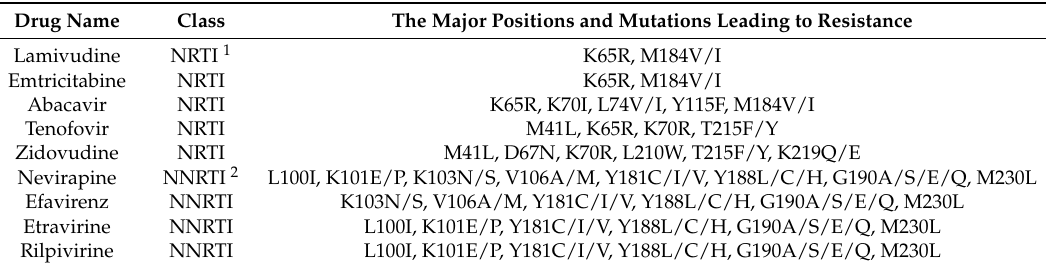
Table 1. The mutations and their combinations leading to drug